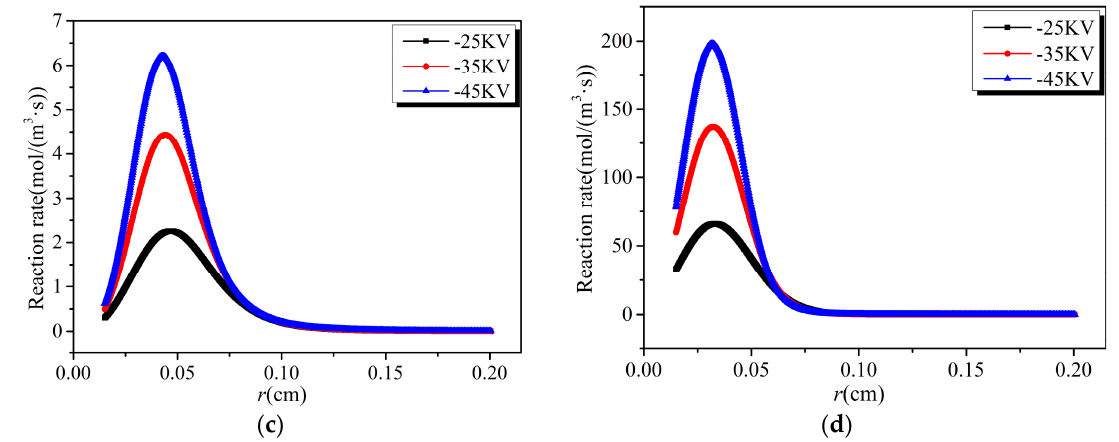
Figure 5. Effect of discharge voltage on reaction rates of electron collision reactions: ( a ) e + O 2 → e + O + O; ( b ) e + O 2 → e + O + O( 1 D); ( c ) e + N 2 → e + N 2 (A); and ( d ) e + N 2 → e + N + N.